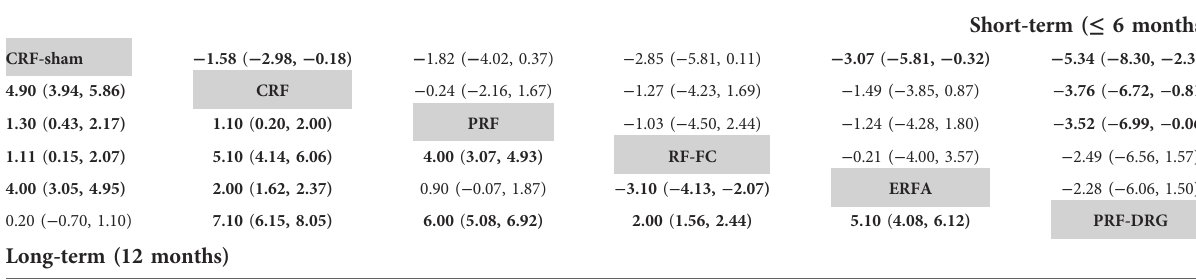
TABLE 1 League table for NMA of change in mean VAS score from